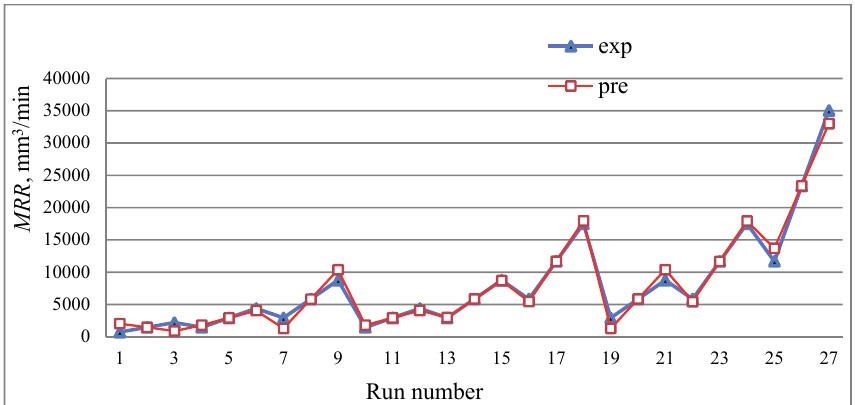
Fig. 5. Comparison between the predicted (pre) and calculated (exp) values for